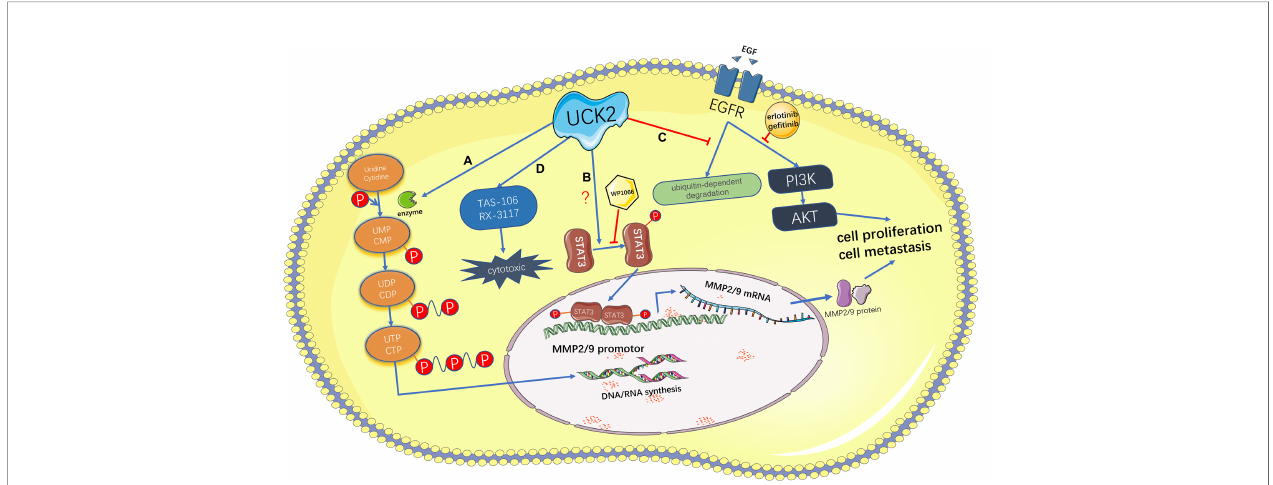
FIGURE 3 | Schematic representation of the catalytic-dependent and -independent features of UCK2 and the therapeutic potential of UCK2 in cancer treatment. (A) As a rate-limiting enzyme of the pyrimidine salvage synthesis pathway, UCK2 phosphorylates uridine and cytidine to uridine monophosphate (UMP) and cytidine monophosphate (CMP), respectively. (B) UCK2 can activate the STAT3-MMP2/9 axis to promote tumor cell proliferation and metastasis, but the underlying mechanism remains elusive. This non-catalytic function of UCK2 can be inhibited by a STAT3 inhibitor, WP1066. (C) By inhibiting EGF-induced EGFR ubiquitination and degradation, UCK2 can activate EGFR-AKT pathway to promote tumor cell proliferation and metastasis. This non-catalytic function of UCK2 can be inhibited by EGFR inhibitors: erlotinib and ge fi tinib. (D) UCK2 can be utilized to catalyze cytotoxic ribonucleoside analogs, such as TAS-106 and RX-3117, for cancer